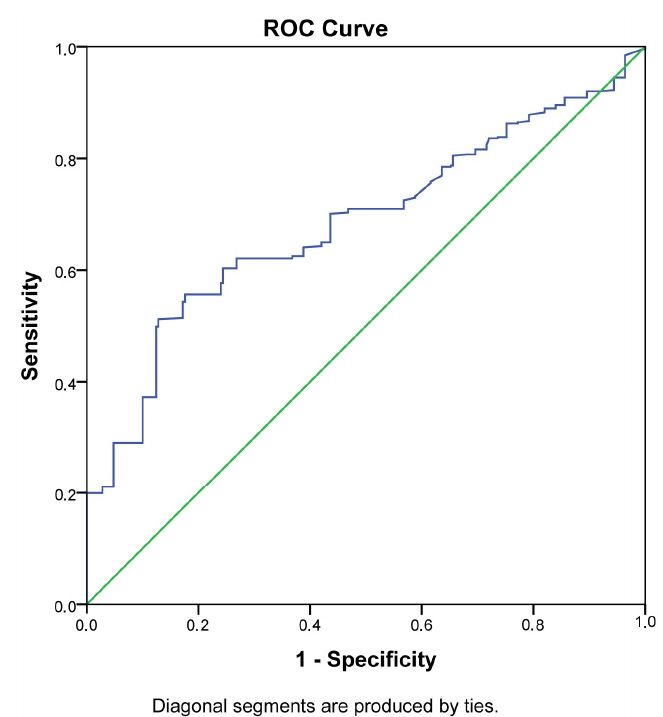
Figure 1. ROC curve of PlGF in the prediction and diagnosis of GDM.